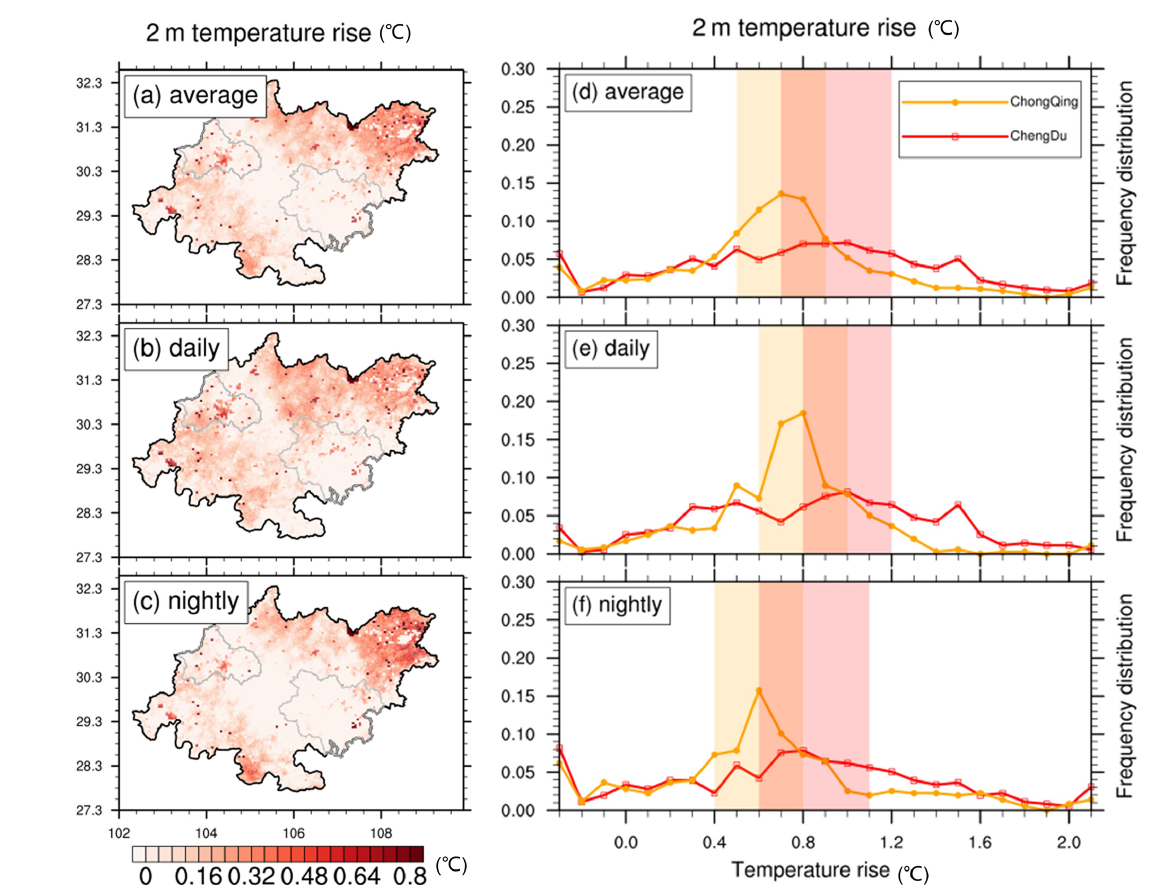
Figure 8. The spatial distribution of 2m temperature rise due to the urbanization: (a) average, (b) daily and (c) nightly. The temperature rise frequency distribution: (d) average, (e) daily and (f) nightly. (“Daily” means the average variable during the daytime, and “nightly” means the average variable during the nighttime. This description also applies to Fig. 10